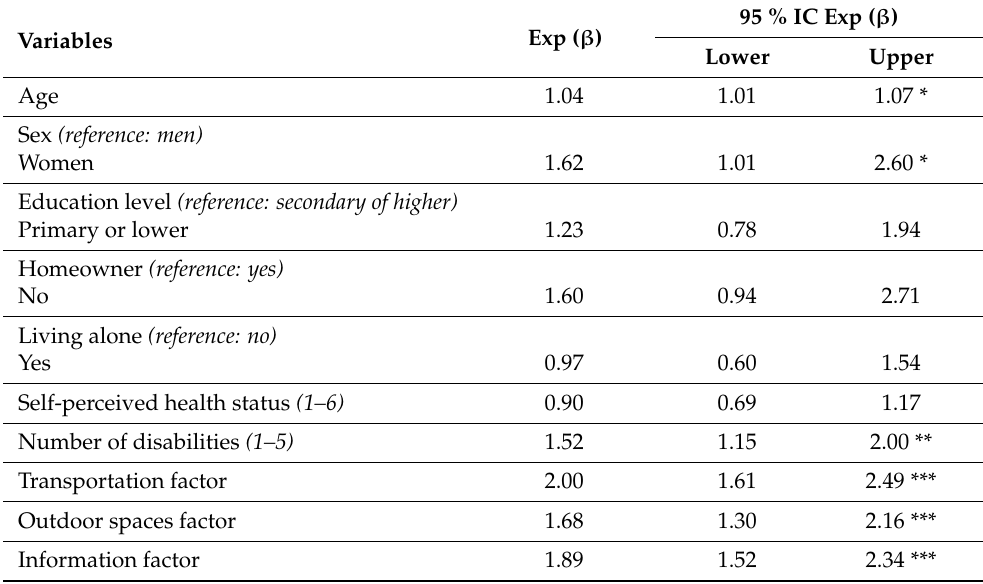
Table 3. Logistic regression model on the probability of needing help to move in the community.